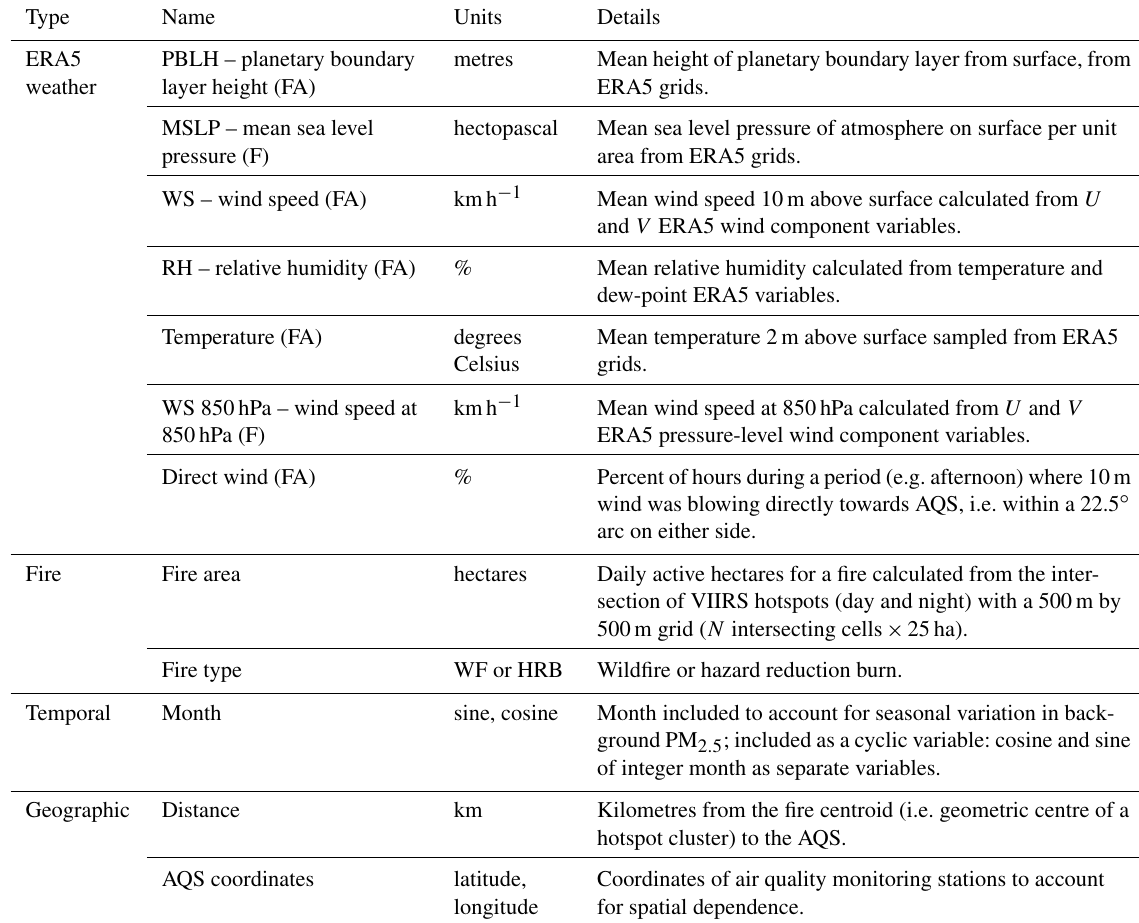
Table 1. Predictor variables used for random forest modelling. Letters mean that for the random forest modelling weather variables were sampled at the fire (F), at the AQS (A) or both (FA). MSLP and wind speed (850hPa) at the AQS were excluded due to being highly correlated with the same variable at the